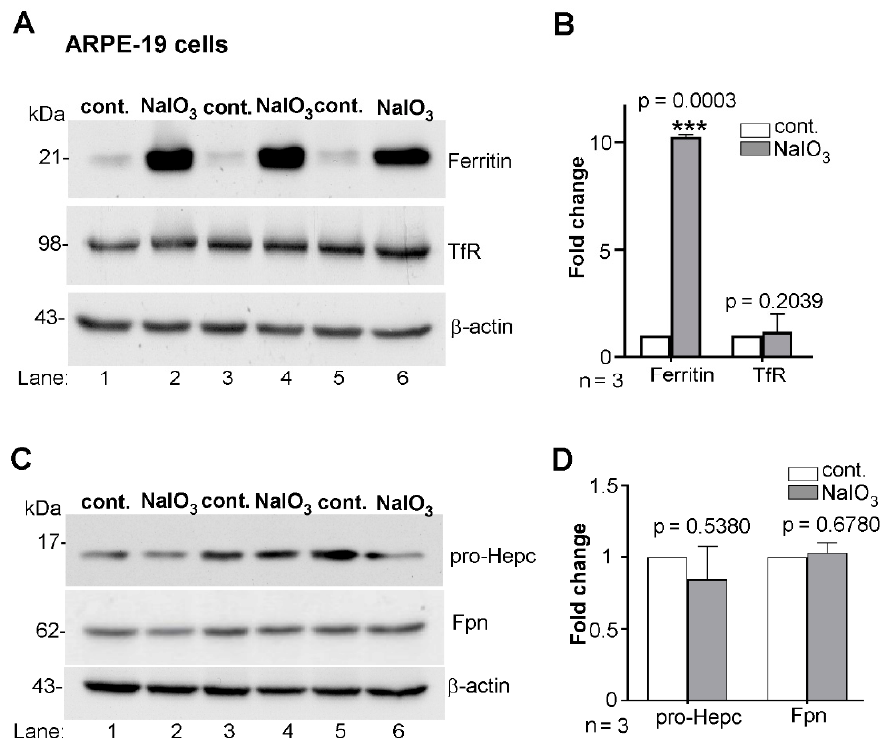
Figure 1. NaIO 3 upregulates ferritin in ARPE-19 cells without altering other iron modulating proteins. ( A ) Probing of lysates from ARPE-19 cells exposed to 10 mM NaIO 3 for 24 h for ferritin revealed significant upregulation relative to vehicle treated controls (lanes 2, 4, 6 vs. 1, 3, 5). Re-probing of the same membrane for transferrin receptor (TfR) showed no significant change in their levels between the experimental and control groups (lanes 2, 4, 6 vs. 1, 3, 5). ( B ) Densitometry after normalization with β -actin showed a 10-fold increase in ferritin and minimal change in TfR by NaIO 3 treatment relative to controls. ( C ) Probing of lysates from a similar experimental setup for pro-hepcidin and Fpn showed no significant change in their levels by NaIO 3 -treatment relative to controls (lanes 2, 4, 6 vs. 1, 3, 5). ( D ) Densitometry after normalization with β -actin shows non-significant changes in the levels of pro-hepcidin and Fpn between experimental and control samples. Full blots and their details are provided in Supplementary Figure S1. Values are means ± SEM of the indicated n . *** p ≤ 0.001.